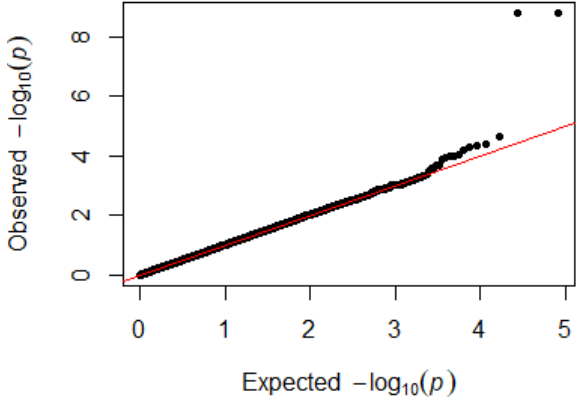
Figure 1. Quantile–quantile plots of p -values for H / L. The x-axis is the expected − log10 p -value and the Figure 1. Quantile – quantile plots of p -values for H/L. The x-axis is the expected − log10 p -value and y-axis is the observed − log10 p the y-axis is the observed − log10 p -value.